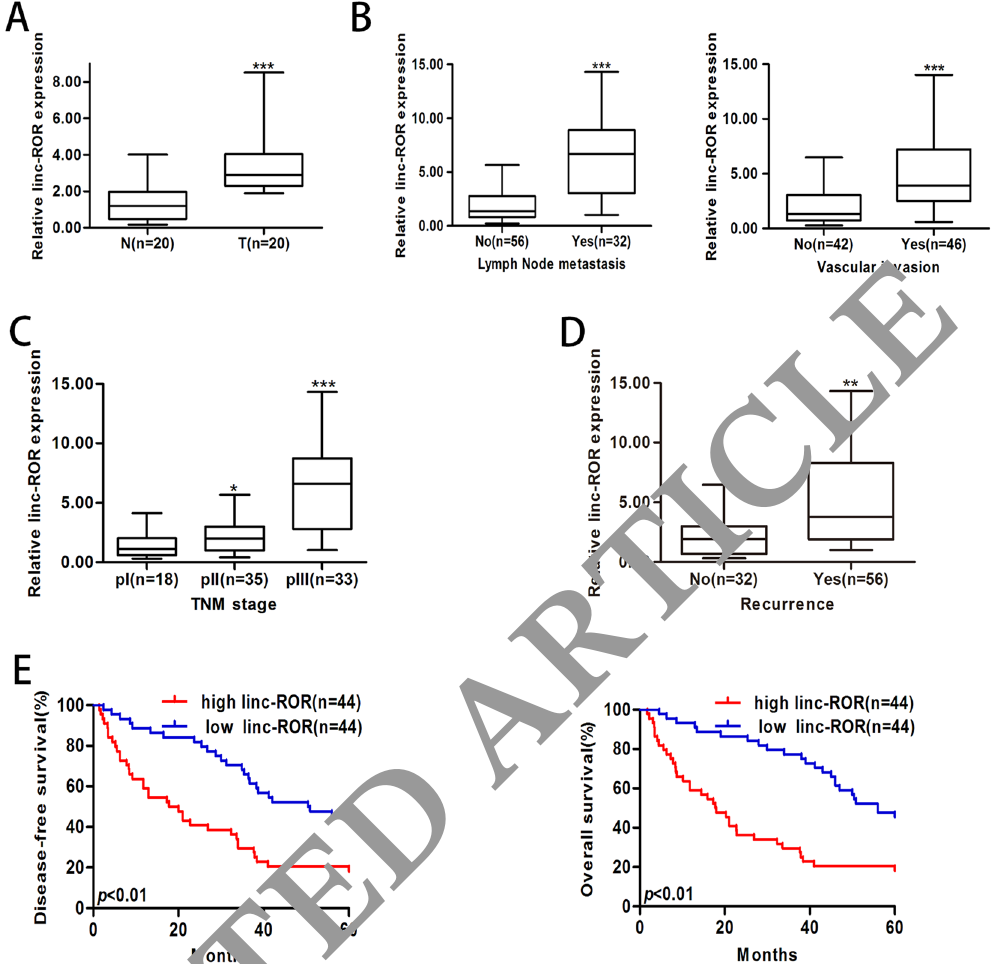
Figure 1. Increased linc-ROR correlates with HCC progression. Expression of linc-ROR was determined by qRT-PCR. GAPDH was used as an endogenous control. ( A ) Relative linc-ROR expression in HCC and paired adjacent nontumor liver tissues. T: HCC tissues; N: nontumor liver tissues. ( B ) Relative linc-ROR expression in HCC tissues with or without LNM and HCC tissues with or without vascular invasion. ( C ) Relative linc-ROR expression in HCC tissues with different TNM stage. ( D ) Relative linc-ROR expression in HCC tissues with or without recurrence. ( E ) Kaplan-Meier analysis of DFS or OS of HCC patients. Patients were grouped according to ROR expression in HCC tissues. The median expression level was used as the cutoff. Each experiment was performed at least three times. * p < 0.05, ** p < 0.01 and *** p <